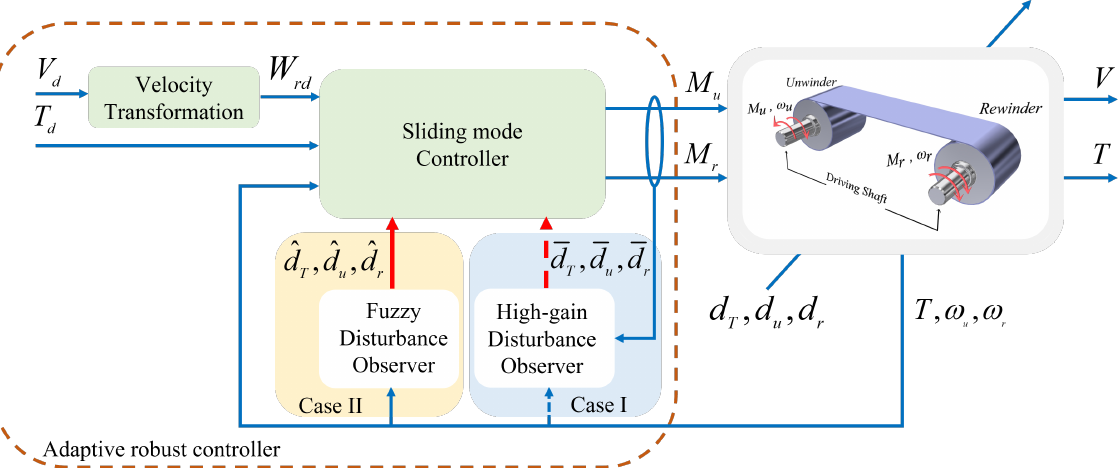
Figure 4. Block diagram of adaptive robust controller. In case I, a high-gain disturbance observer-based sliding mode controller is used, and in case II, a fuzzy disturbance observer-based sliding mode controller is